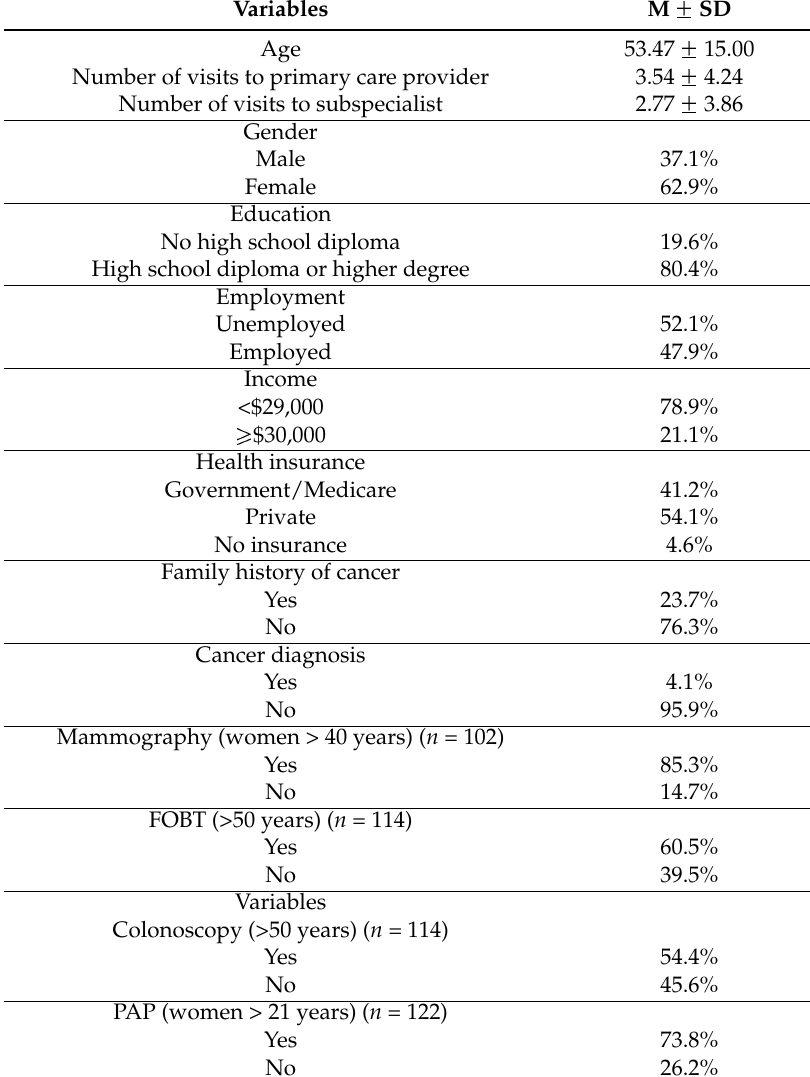
Table 1. Demographic factors and cancer screening